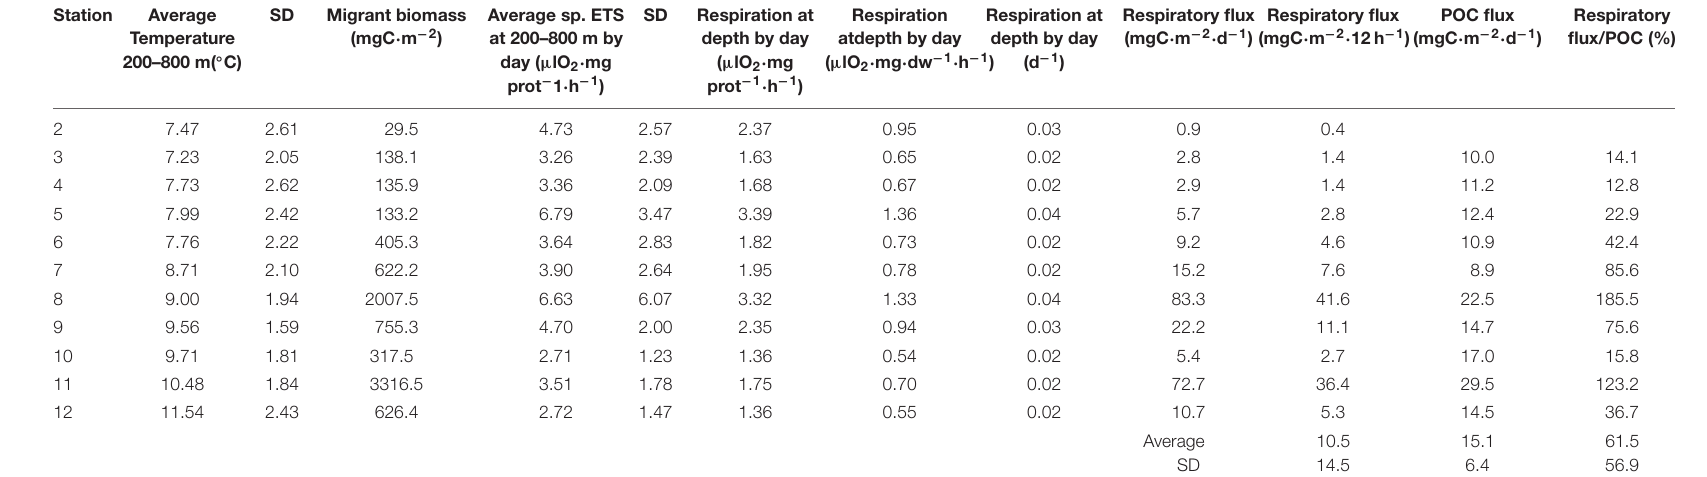
TABLE 1 | Average temperature and zooplankton migrant biomass, ETS activity, respiration rates, and respiratory flux along the tropical and subtropical Atlantic Ocean.